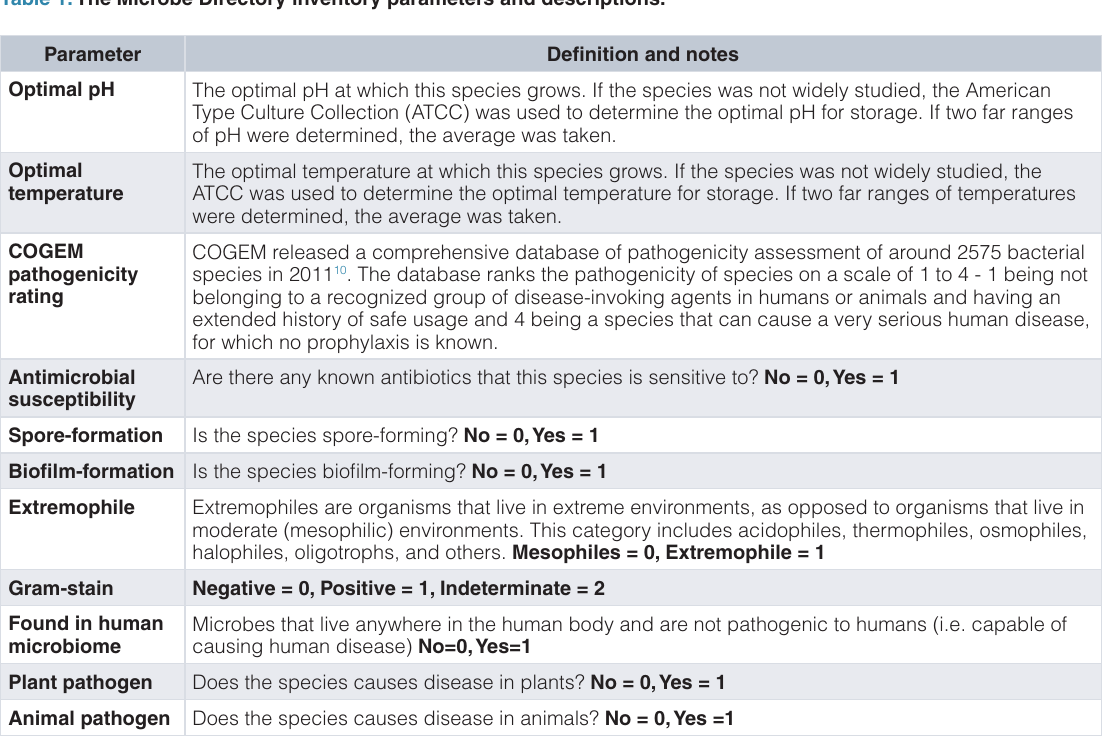
Table 1. The Microbe Directory inventory parameters and